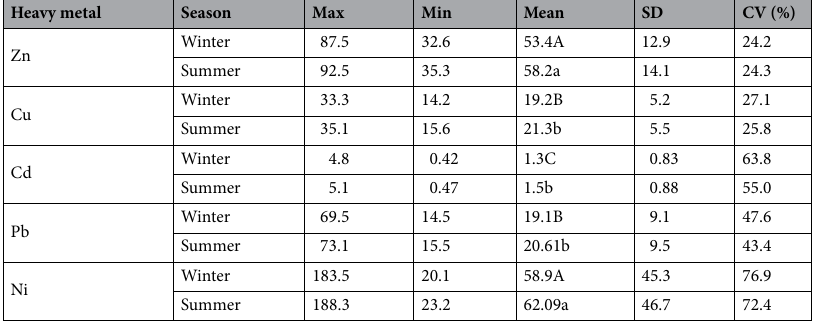
Table 3. Summary statistics of heavy metal in the study sediment during summer and winter. The capital letters separate means of winter sediments’ heavy metal concentrations and lower-case letters separate